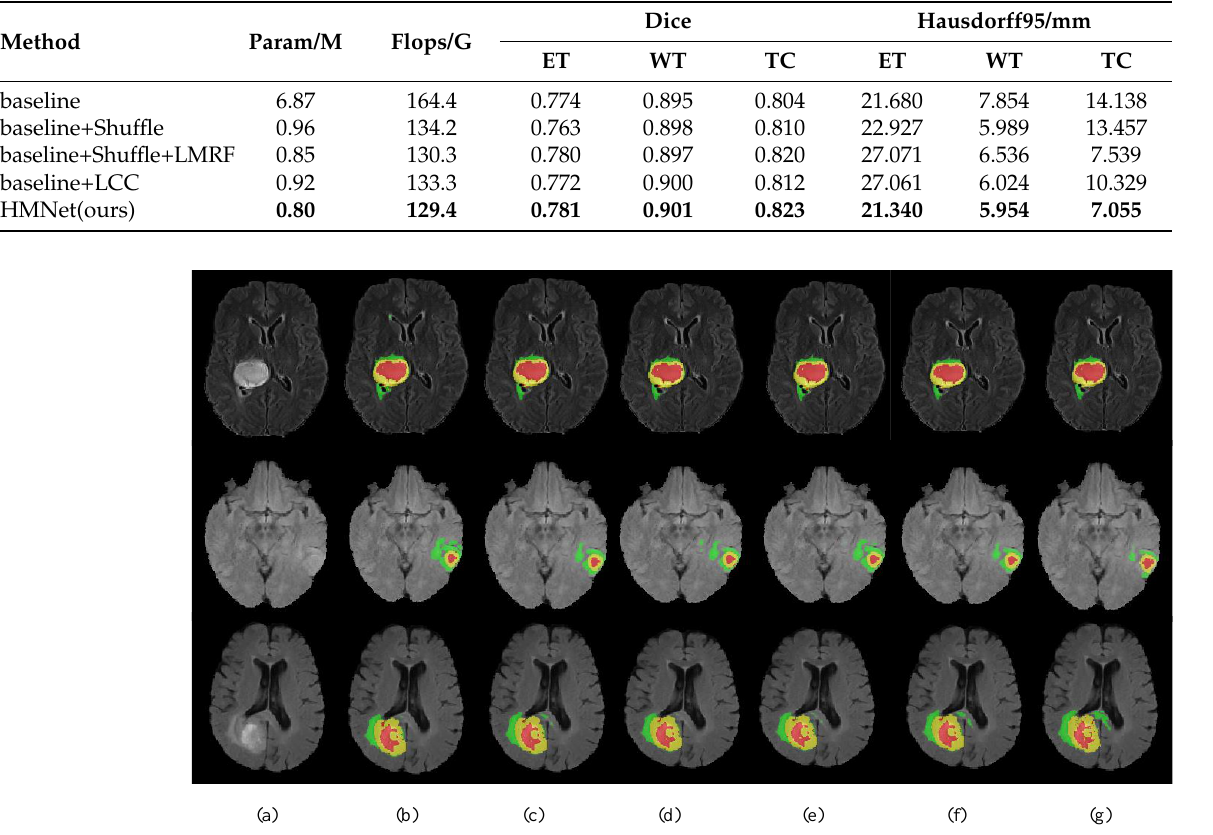
Figure 9. Visualization of segmentation results. Each row represents a different sample. ( a ) is the modality of Flair. ( b – g ) are the segmentation results of Network 1 to Network 5 in Table 8 and the ground truth. The yellow area is the enhancing tumor area. The red area is the necrosis and non-enhancing area. The green area is the edema